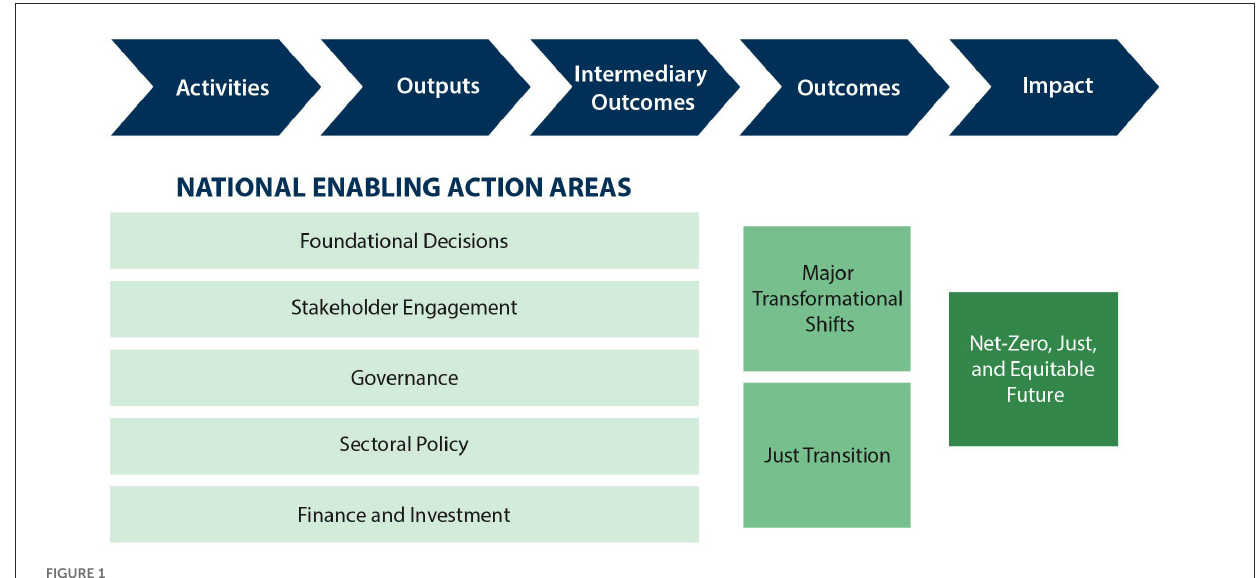
FIGURE1 Logical framework for net-zero climate action.